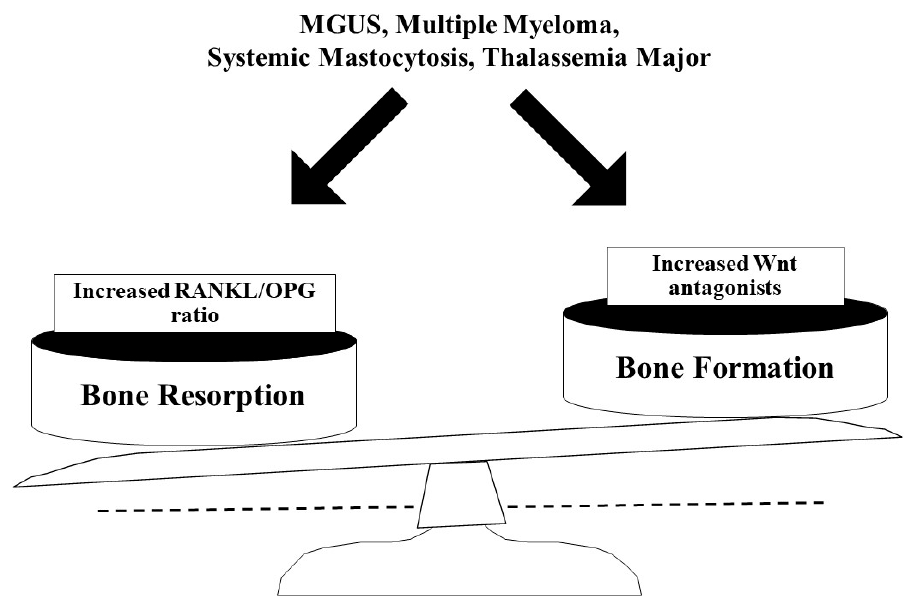
Figure 3. Unbalanced bone turnover in hematological diseases. MGUS: monoclonal gammopathy of undetermined significance; RANKL: receptor activator of NF- κ B ligand; OPG: osteoprotegerin.